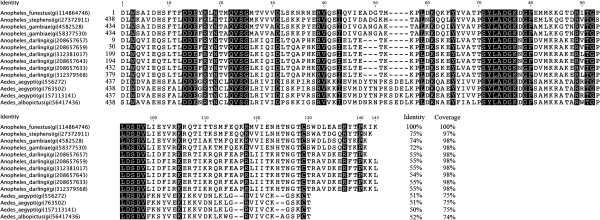
Alignment of Culicidae protein members from the 5′ nucleotidase/Apyrase family. Using the BLASTp program, 13 Culicidae protein sequences related to 5′nucleotidase (gi|114864746) from An. funestus were selected (E-value<1.10-4, coverage ≥70% and identity ≥ 50%). An alignment of Culicidae 5′nucleotidase/apyrase proteins to 5′nucleotidase from An. funestus (f5′nuc, gi|114864746) was performed with ClustalW. Only the parts of the protein sequence aligned with the f5′nuc protein sequence are presented. Mosquito species, protein name, accession numbers and amino-acid positions are indicated, and conserved amino acids are shaded. The percentages of identical amino acid residues and sequence recovering compared with f5′nuc (gi|114864746) are listed for each of the selected proteins.